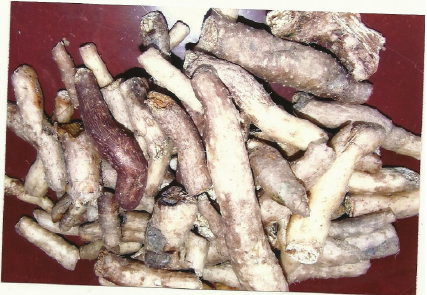
Figure 1: Dioscorea steriscus